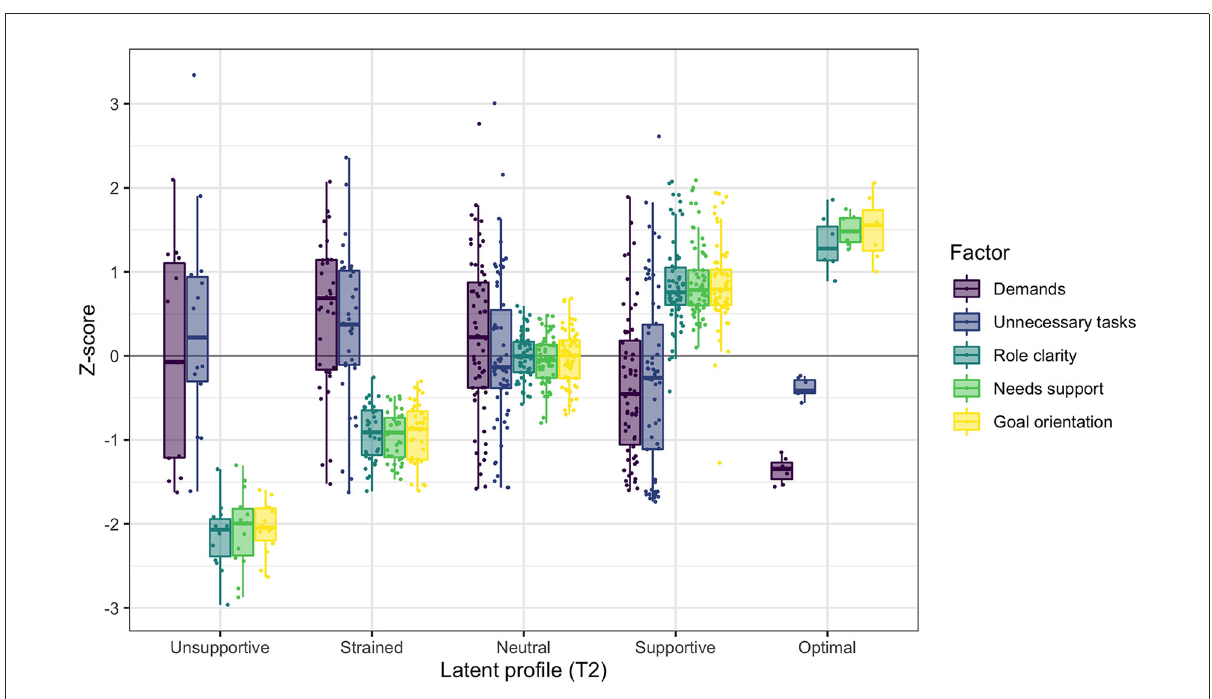
FIGURE2 Co-care profiles at T2, illustrated with boxplots and individual data points of the co-care factor z scores ( M = 0, SD = 1).